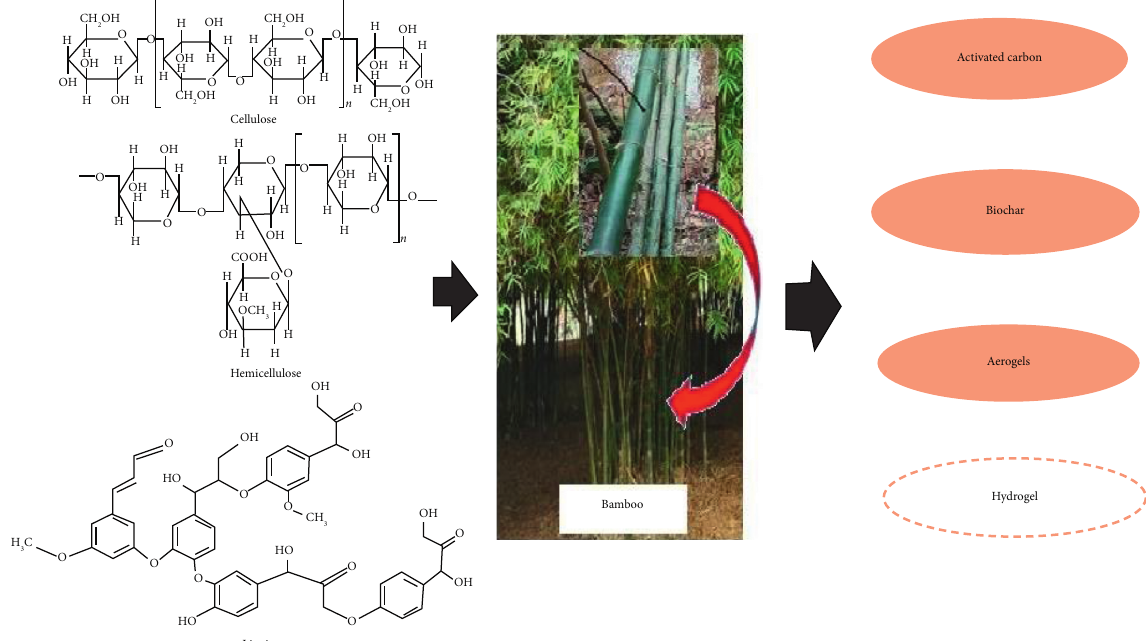
Figure 1: Bamboo main compositions and its